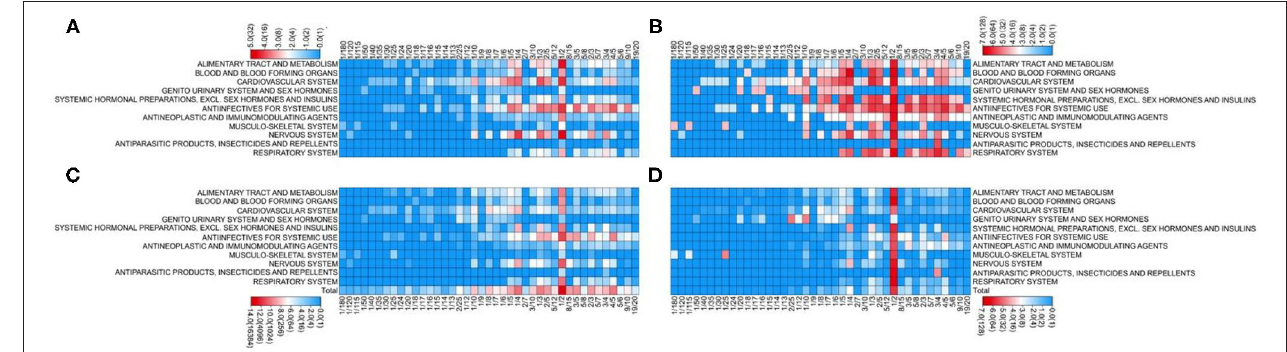
FIGURE 2 | Manipulated medications and prescriptions according to the medication classification. (A) Number of manipulated medications. (B) Proportion of manipulated medications relative to all prescribed medications (%). (C) Number of manipulated prescriptions. (D) Proportion of manipulated prescriptions relative to all prescriptions